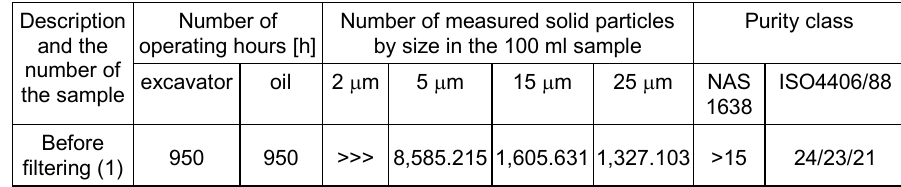
Table 1 – Content of solid particles in the oil mass of the excavator hydraulic